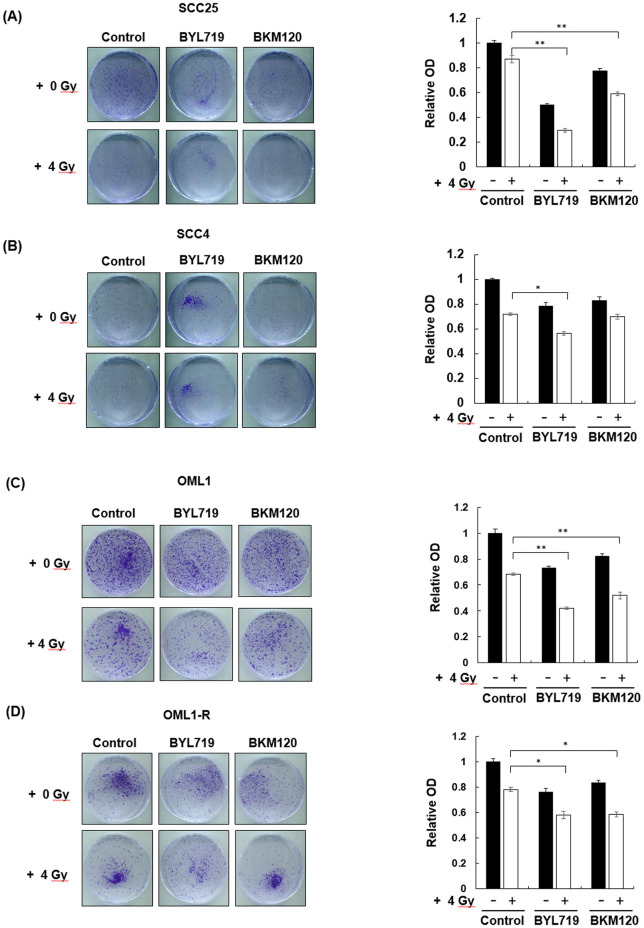
Enhanced radiosensitivity upon IR exposure combined with BKM120 or BYL719 treatment in OSCC and radioresistant OML1-R cells.SCC4, SCC25, and OML1-R cells were pretreated with BKM120 or BYL719 at 2 μM and then irradiated at 0 or 4 Gy. After 14 days, colonies were stained with crystal violet and quantified by an ELISA reader. Data are presented as mean ± SD, and the asterisks indicate significant difference. *P < 0.01 compared with the control group.